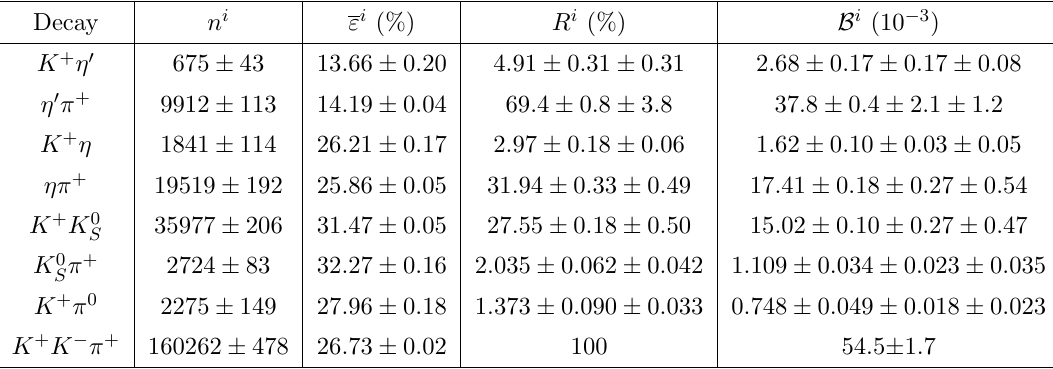
! K + K (cid:0) (cid:25) + [6]. The s